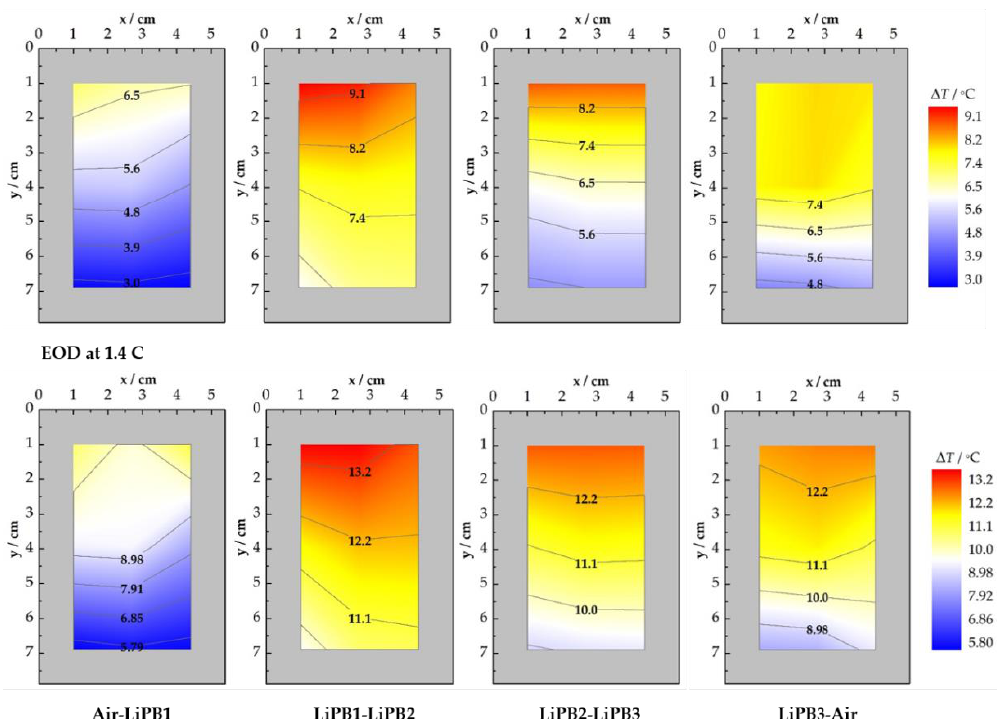
Figure 8. Spatial and temporal thermal mapping of the LiPBs pack when the CC discharge at 1.4 C begins and ends.